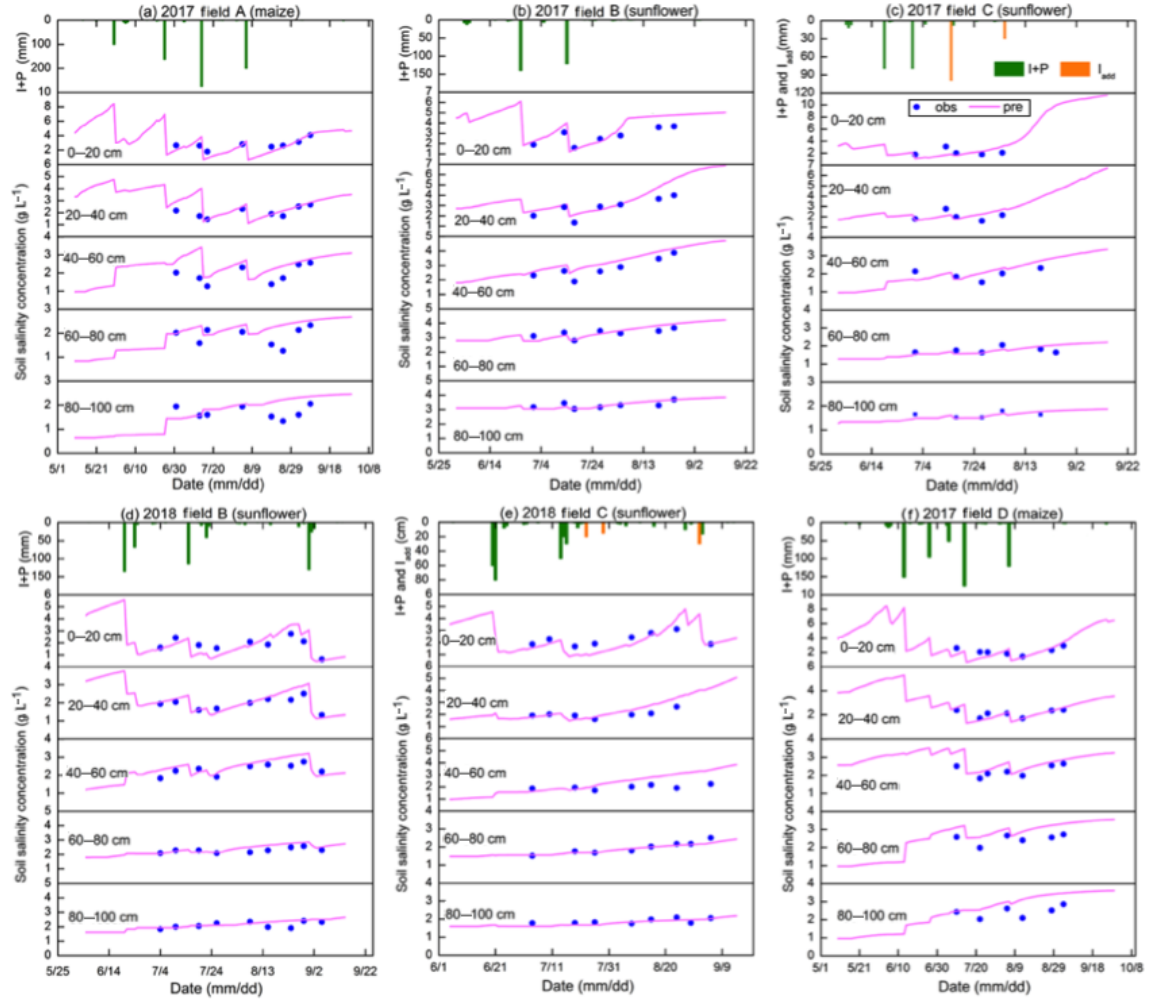
Figure 6. Observed (blue dots) and simulated soil salinity concentration of the experimental fields in Shahaoqu during model calibration (a–c) and validation (d–f)